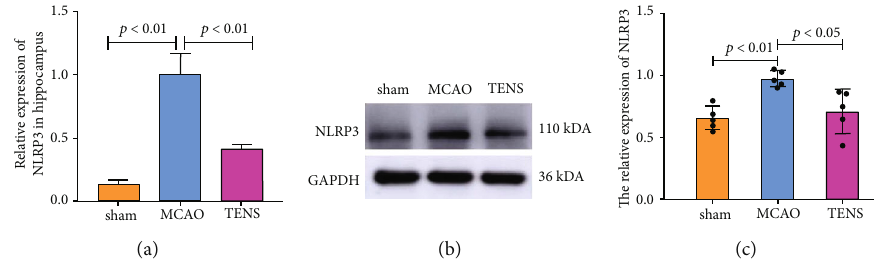
Figure 4: The e ff ect of TENS treatment on NLRP3 expression. (a) NLRP3 expression in the injured hippocampus was detected by real-time PCR, in which GAPDH was used for the loading controls. (b) The NLRP3 expression was detected by western blot. (c) Statistical analysis showing the expression di ff erence of NLRP3 and BRCC3 in the injured hippocampus among three